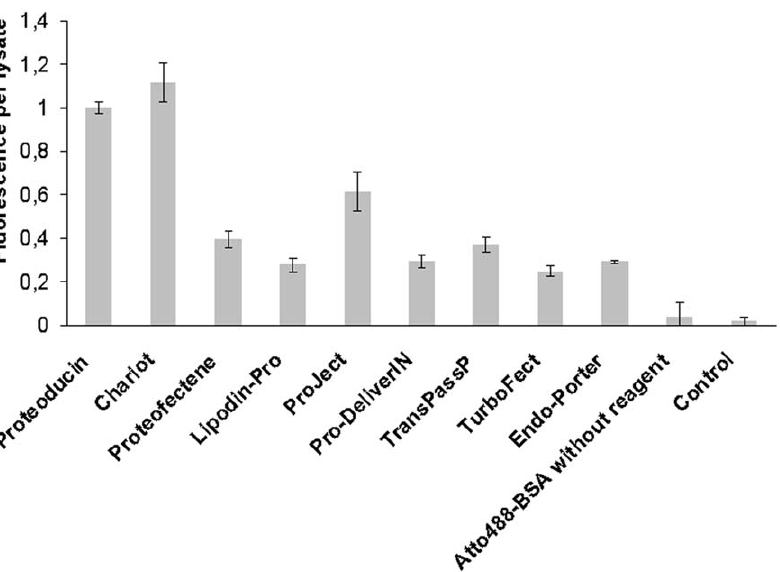
Figure 1. Fluorescence signal per lysate after transduction. The fluorescence intensity of the lysed cells per well was measured in a multiwell fluorescence reader. The intensities were normalized to the mean intensity produced by the transfection using Proteoducin as transduction reagent. The sarcoma cells were transduced with Atto488-BSA using different transduction reagents. Untreated sarcoma cells were measured as controls. As a control for standard endosomal uptake, sarcoma cells were treated with DMEM containing 0.5 m g Atto488-BSA without a transduction reagent (termed as Atto488-BSA). Error bars represent the 95% confidence intervals of the means. Each transduction reagent was tested in at least 6 independent experiments.